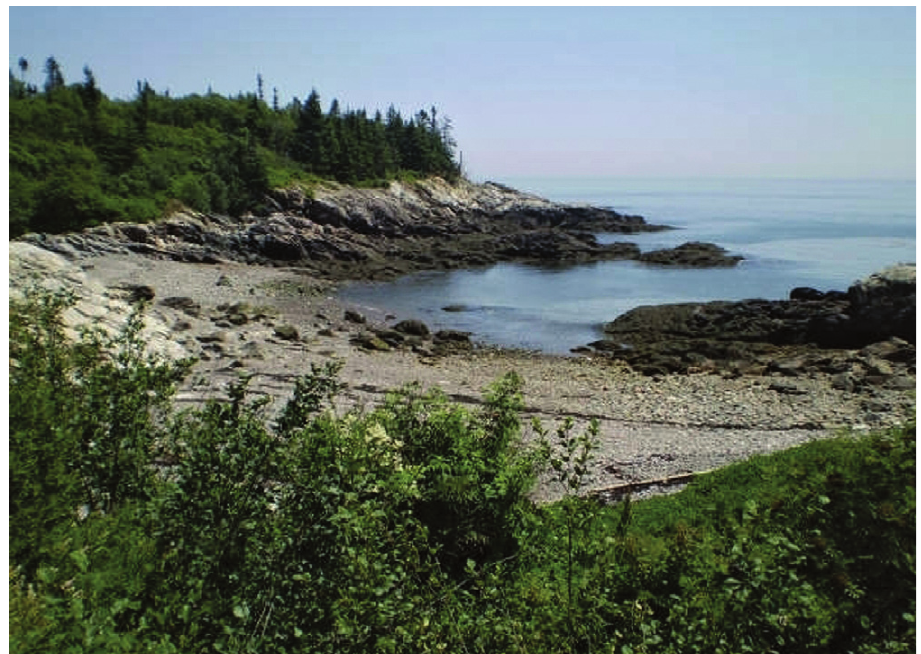
Fig. 14. Habitat of D. mersa and H. fl avipes (near Dipper Harbour, New